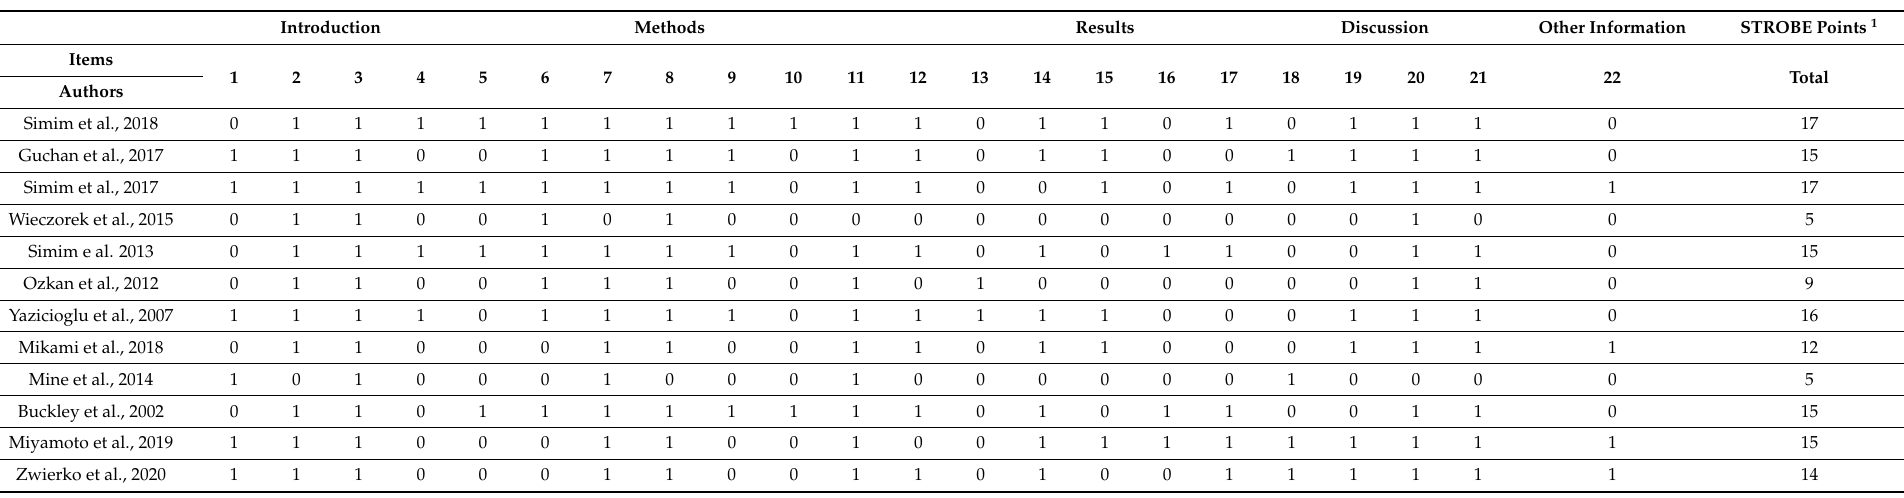
Table 4. The STROBE qualitative assessment of included